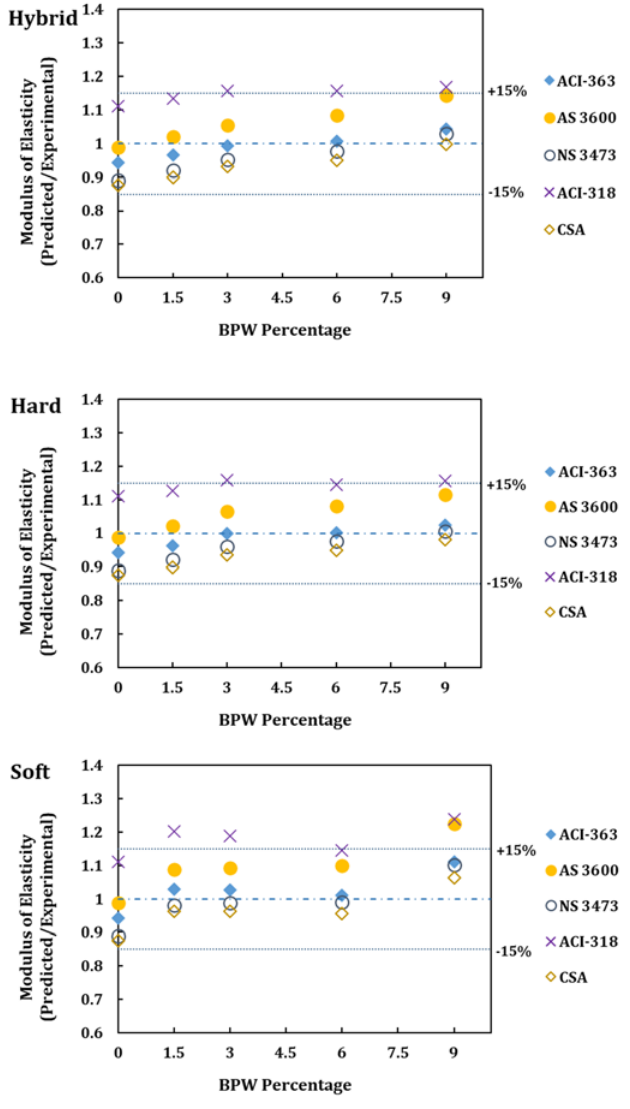
Figure 18. The ratio of predicted modulus of elasticity by the compressive strength and unit weight from different design codes for conventional concrete and experimental modulus of elasticity results [16,68,74,76,81].